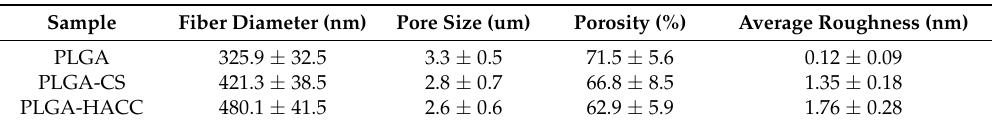
Table 1. Fiber diameter, pore size, porosity and average roughness of PLGA, PLGA-CS and PLGA-HACC electrospun membranes.